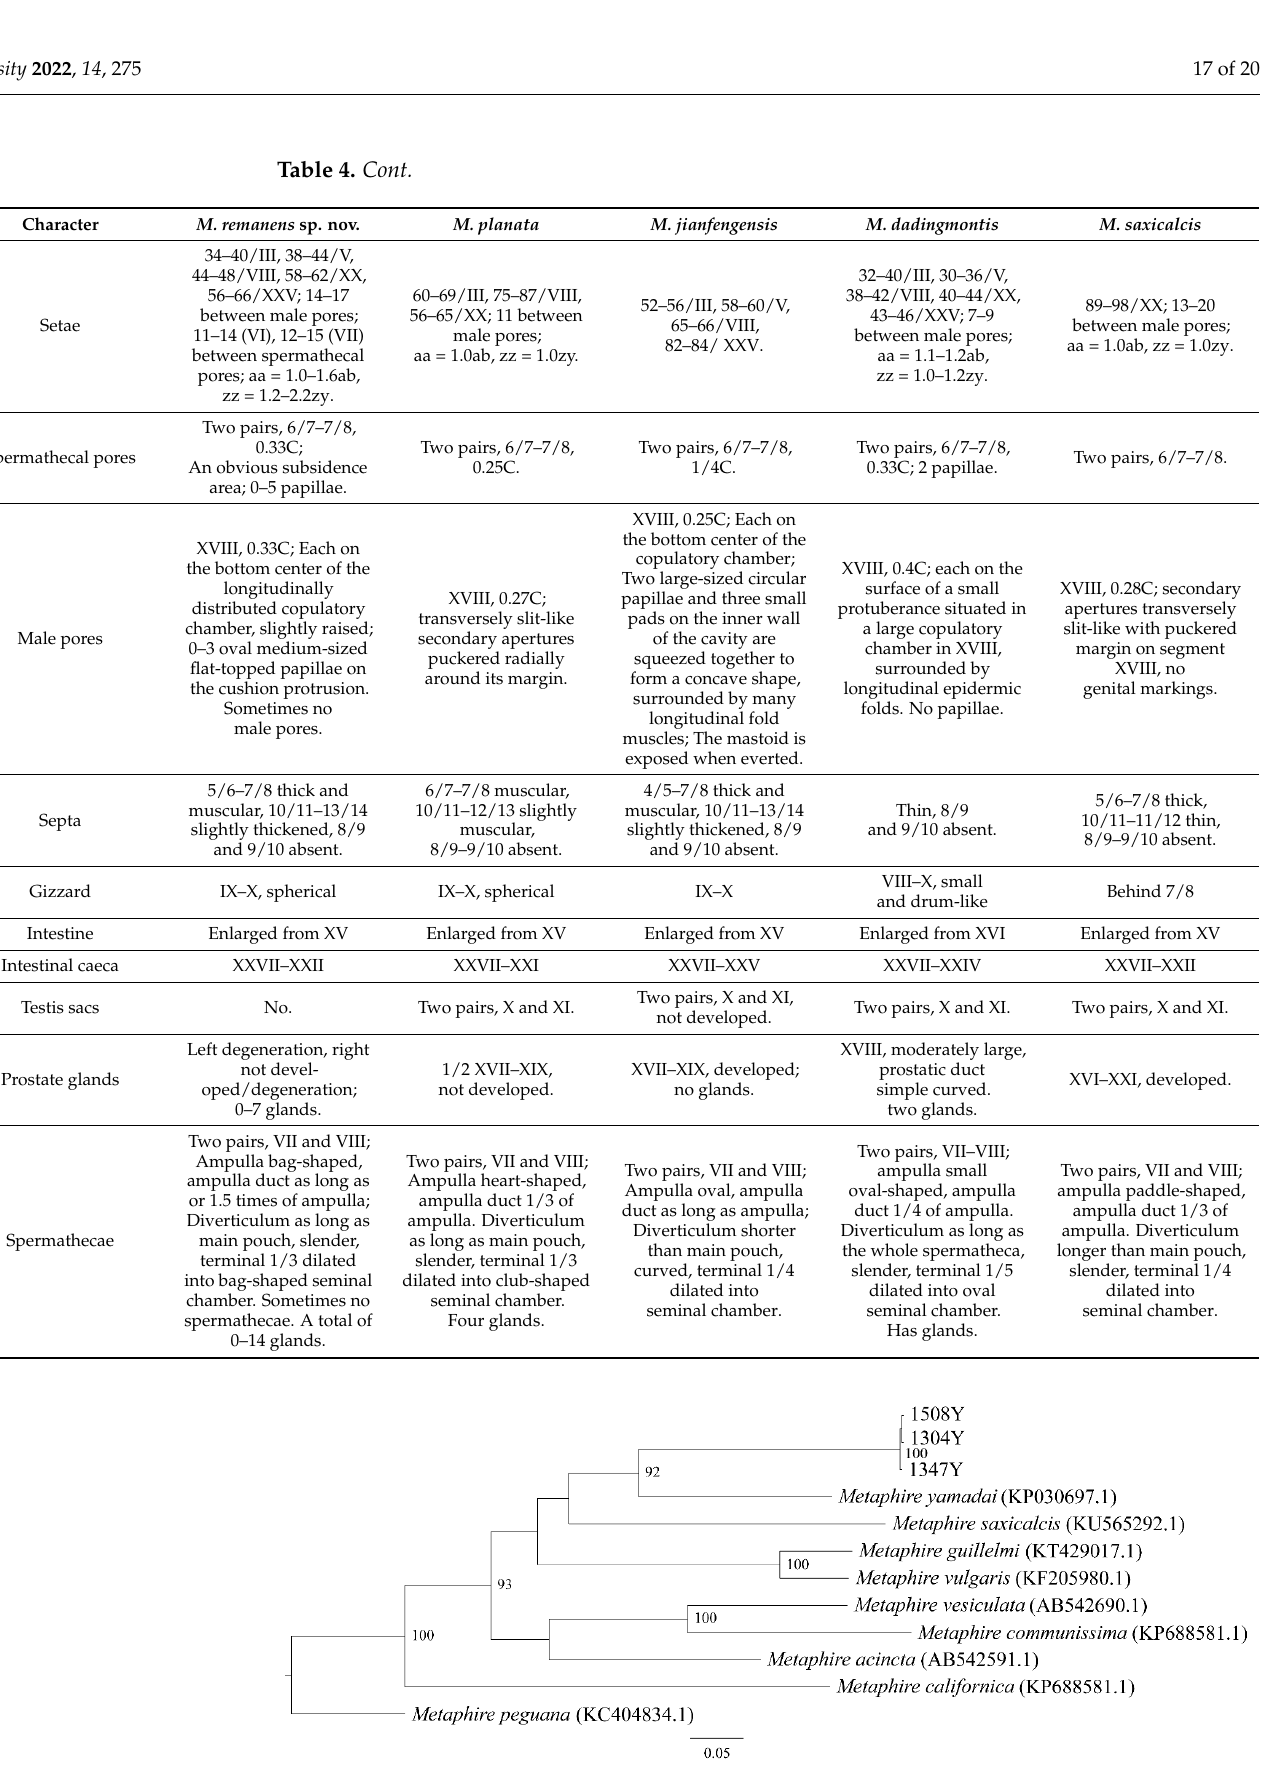
Figure 9. Phylogenetic tree, reconstructed using Bayesian phylogeny estimation, based on COI gene. Bayesian posterior probabilities (pp ≥ 0.95) are shown on the branches. Numbers in parentheses are GenBank accession numbers.